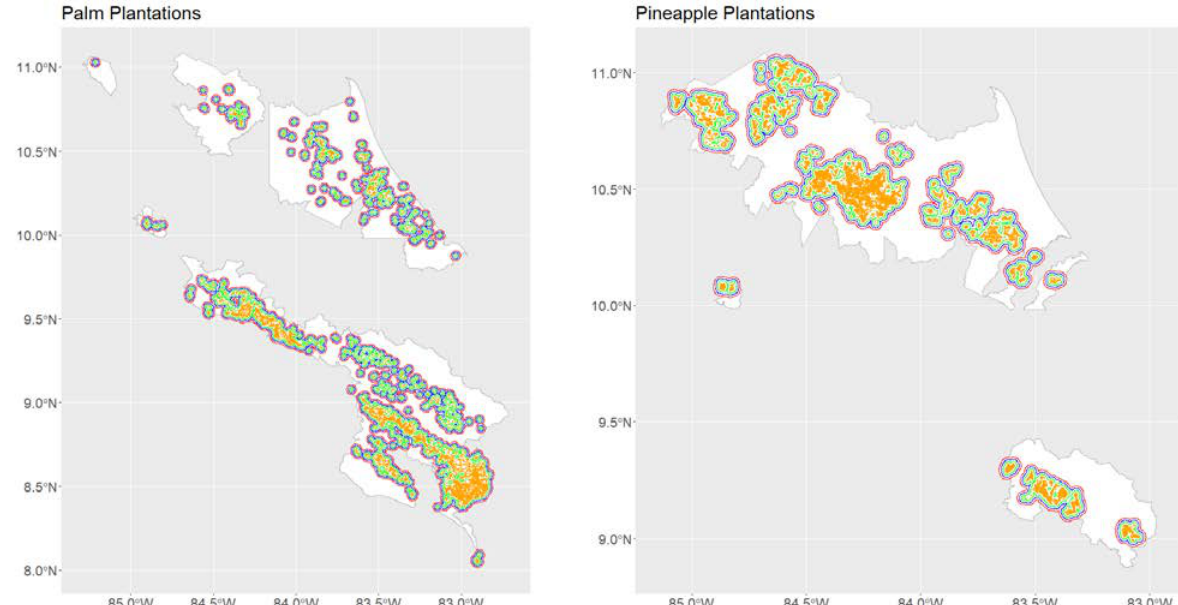
Figure 3. Plantation districts (in white) and plantations (in orange), and the different spatial buffers, 1 km (yellow), 2 km (blue) and 3 km (red), used for comparing Anopheles albimanus habitat suitability between plantations and surrounding land in plantation districts. As indicated by the inset titles, the left panel shows the spatial buffers for oil palm plantations, and the right panel shows those for pineapple plantations.